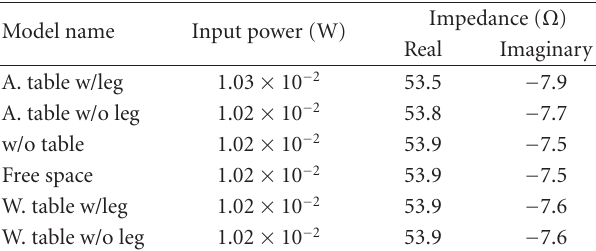
Table 3: Input power and input impedance of the transmitter.